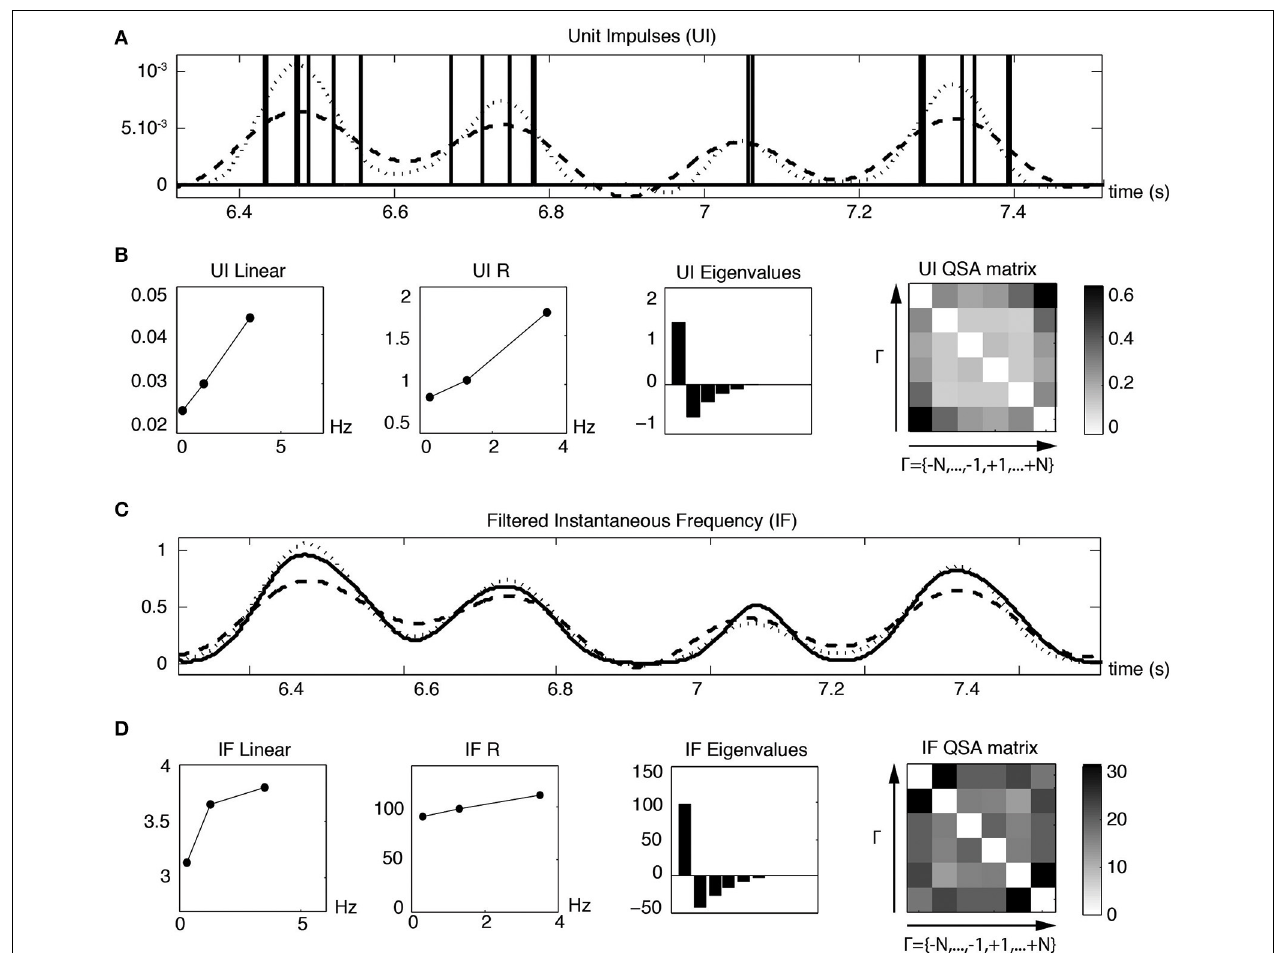
FIGURE 12 | Linear and quadratic responses of unit impulses (UI) to pre-resonance stimulation frequencies ( f 1 = 0 . 3, f 2 = 1 . 3 and f 3 = 3 . 5Hz). (A) Unit impulses corresponding to each action potential event of Figure 11 . The dashed and dotted lines are the reconstructed linear and quadratic components based on the analysis of the second row. (B) Linear and quadratic analyses computed from the Fourier transform of the unit impulses. (C) The solid line is a slightly Gaussian filtered instantaneous